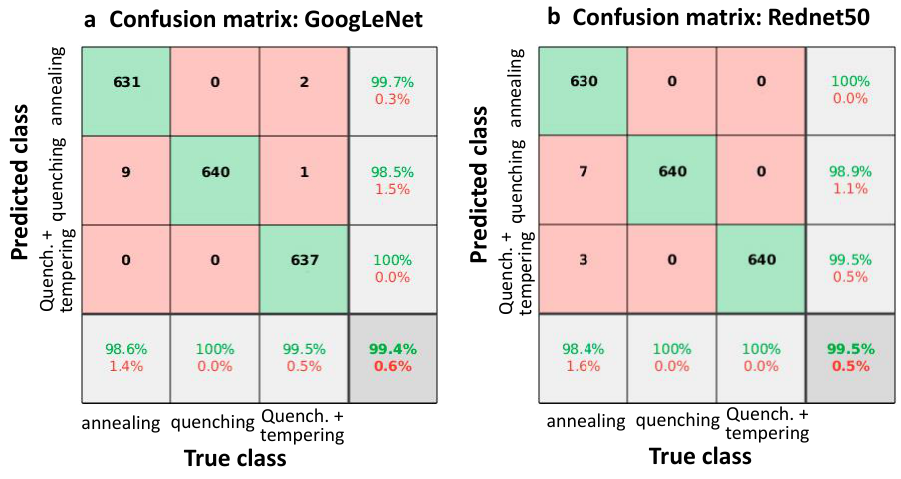
Figure 10. Confusion matrixes for the pre-trained networks, GoogLeNet ( a ) and ResNet50 ( b ) used in transfer learning tests, i.e., corresponding to samples that were not used to train and/or validate the networks.